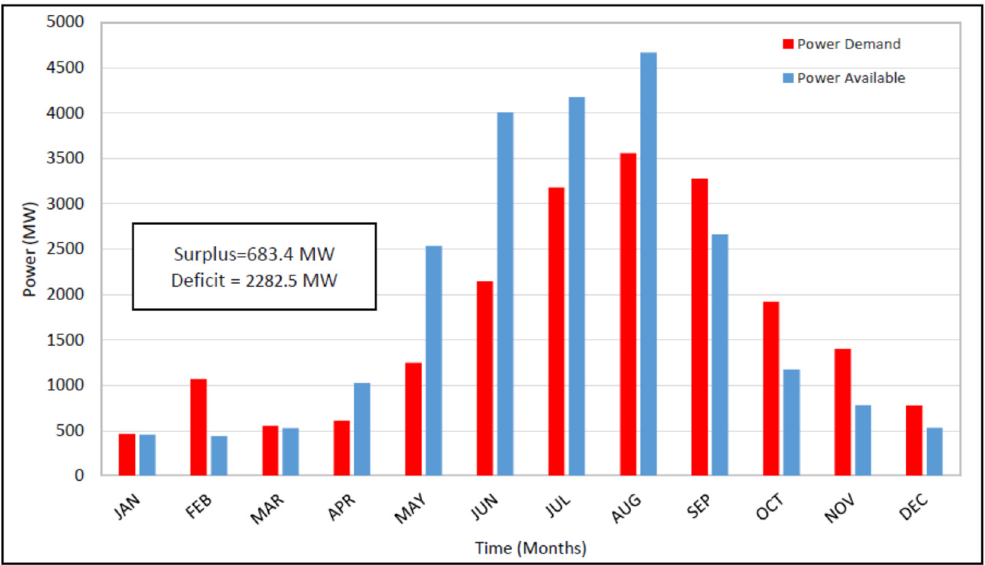
36 of 42 Figure 43. Comparison of Expected Irrigation Releases and Demand in 2035.